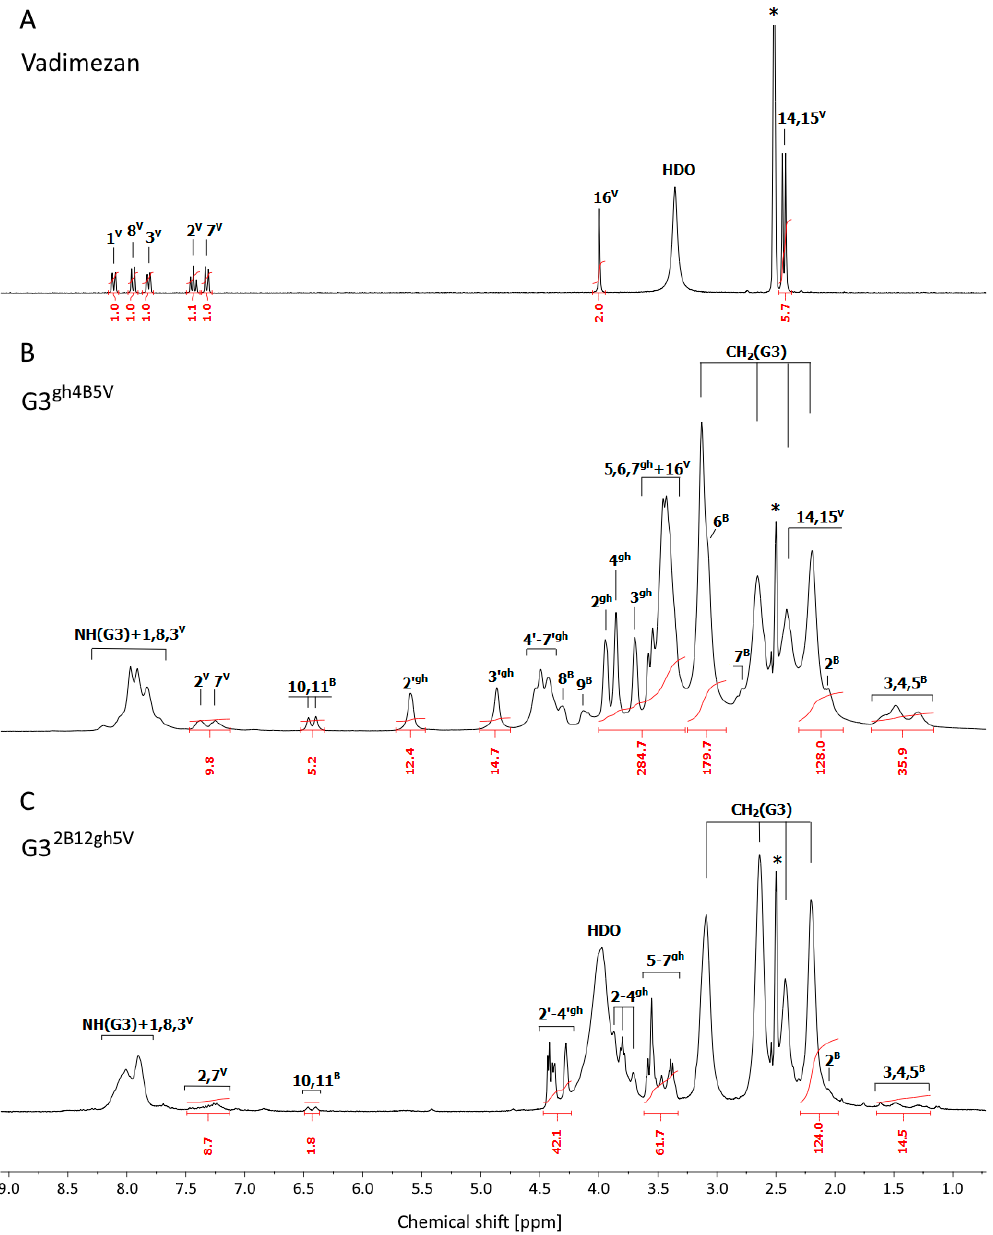
Figure 2. The 1 H NMR spectra of vadimezan ( A ), G3 gh4B5V ( B ) and G3 2B12gh5V ( C ) conjugates in DMSO- d 6 . The residual solvent peak at 2.5 ppm is marked with asterisks *. The PAMAM G3 core dendrimer resonances are labeled as CH 2 (G3) and NH(G3) in spectrum B and C. The resonances of vadimezan, biotin, and glucoheptoamide are labeled by locants with V , B , and gh upper indexes, respectively, according to the atom numbering in Schemes 2 and